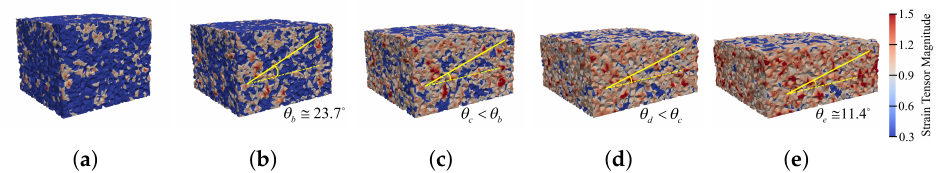
Figure 16. The micro-strain contour evolution during the compaction process of specimen S 8 , ( a ) (cid:101) 3 = 0.1, ( b ) (cid:101) 3 = 0.2, ( c ) (cid:101) 3 = 0.3, ( d ) (cid:101) 3 = 0.4, ( e ) (cid:101) 3 = 0.5.